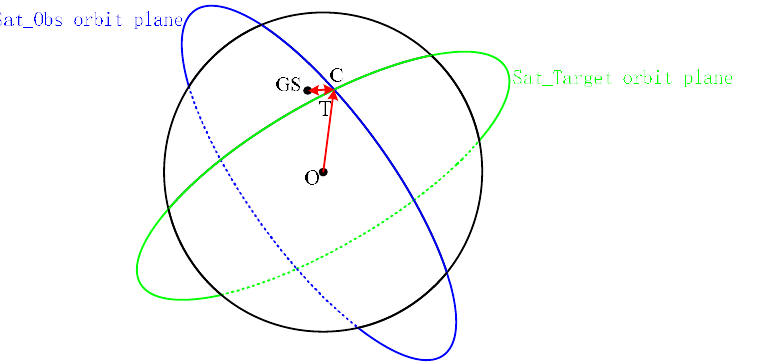
Figure 3. GSA scene building principle.